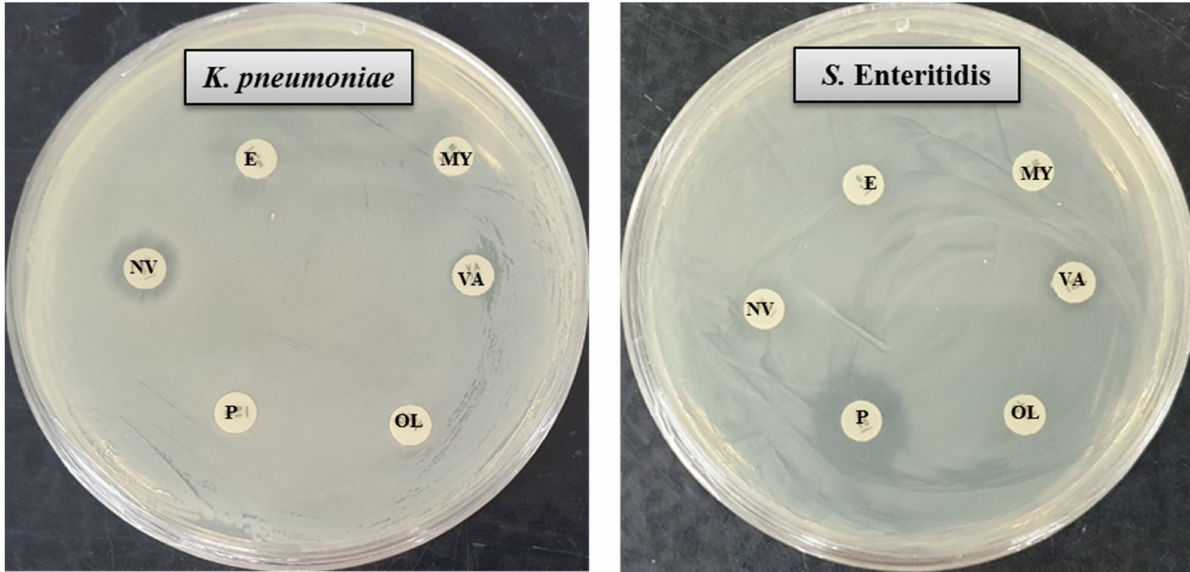
Figure 6. Zones of inhibition of commercial antibiotics against K. pneumoniae and S. Enteritidis. Abbreviations: E (ery- thromycin, 15 µ g/disc), VA (vancomycin, 30 µ g/disc), MY (lincomycin, 15 µ g/disc), OL (oleandomycin, 15 µ g/disc), P (penicillin G, 10 µ g/disc), and NV (novobiocin, 30 µ